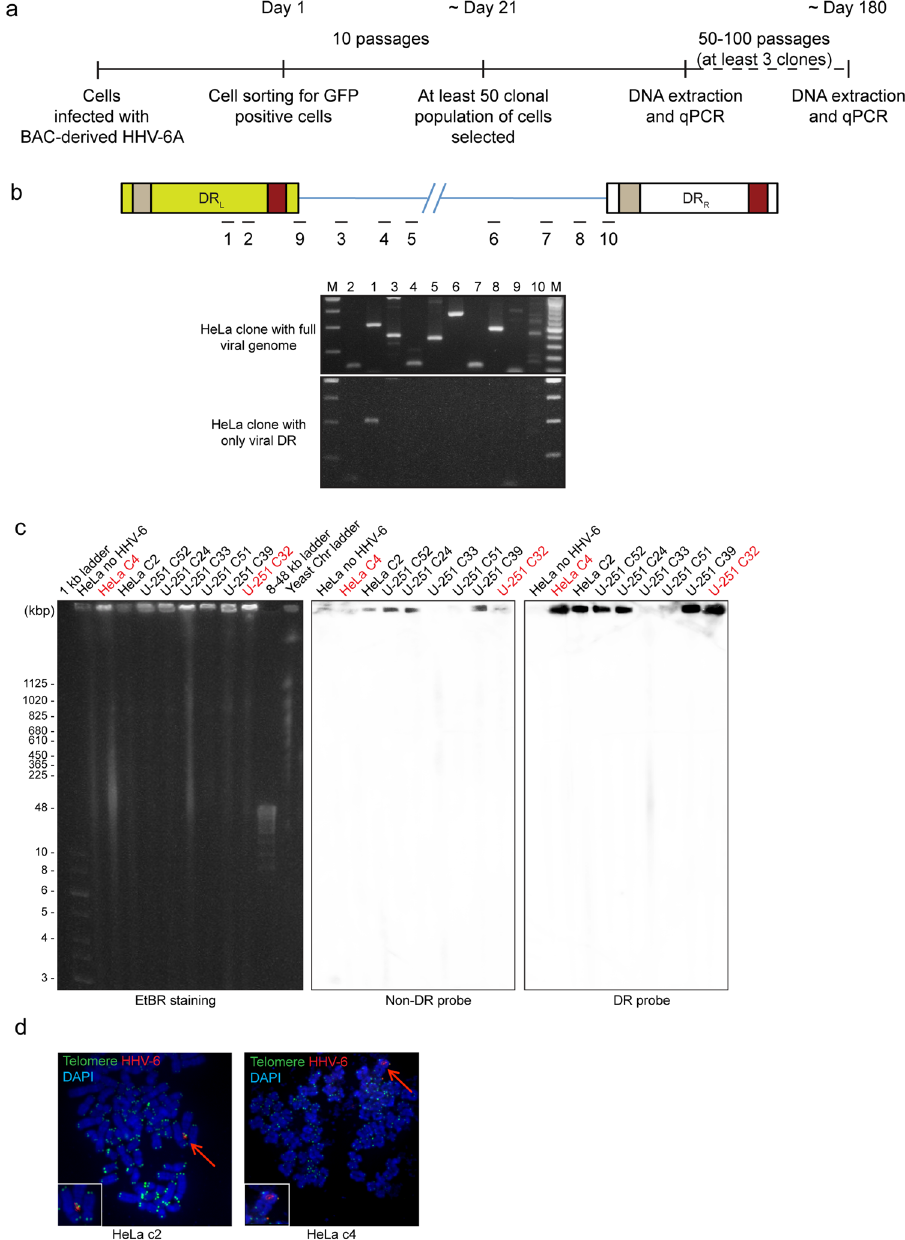
Figure 2. In vitro cell culture infection model to study chromosomal integration of HHV-6. ( a ) Diagrammatic representation of the experimental set up. ( b ) 10 different regions of HHV-6A genome in 2 different clones of HeLa cells were tested by conventional PCR. Upper panel represent approximate location of primer pairs within HHV-6A genome. Lower panel shows ethidium bromide stained agarose gel images showing amplified PCR products. M, 1 kb DNA ladder; 1, DR6; 2, DR7; 3, U22; 4, P41; 5, U42; 6, U79; 7, U83; 8, U91; 9, DRL junction region; 10, DRR junction region. ( c ) Presence of chromosome associated full-length viral genome and viral DR was studied in various HeLa and U-251 clones by PFGE. Blots were first hybridised with a probe that does not detect HHV-6 DR (non-DR probe), stripped and then re-probed with a DR specific probe (DR probe). Cells positive for viral DR alone are indicated in red. ( d ) FISH analysis of integrated HHV-6A in HeLa cells. Left panel shows integrated viral genome in clone 2. Co-staining with telomere specific probe is indicated. The right panel shows the integration of viral DR in clone 4. HHV-6A DR specific probe is used for viral genome detection. Arrowhead indicates integrated viral genome, which is also shown as enlarged images on lower left hand corner of each